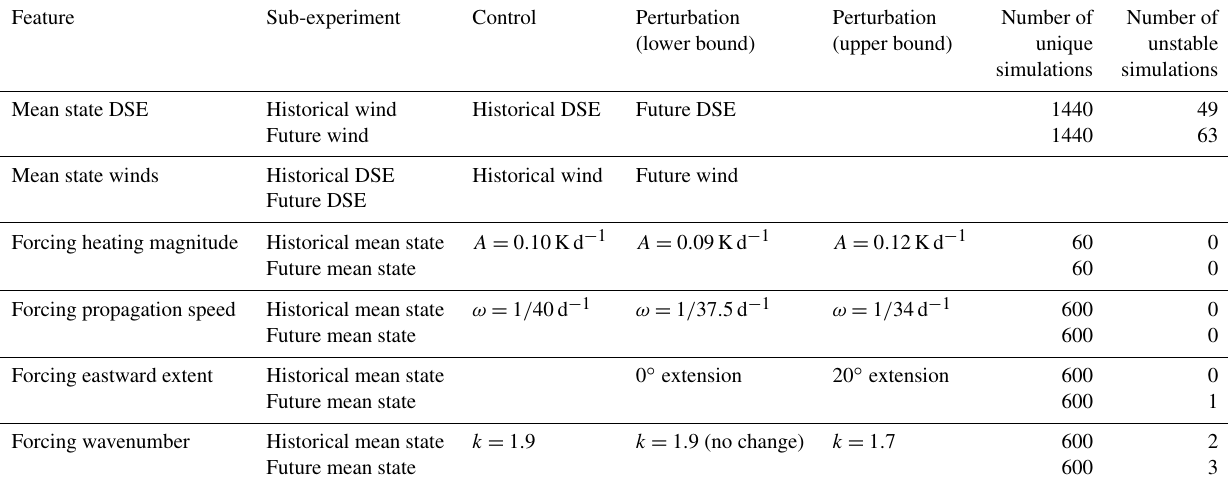
Table 1. Experimental setup for the linear baroclinic model simulations. “Lower bound” and “upper bound” refer only to perturbations of the thermal forcing (last three rows). DSE indicates dry static